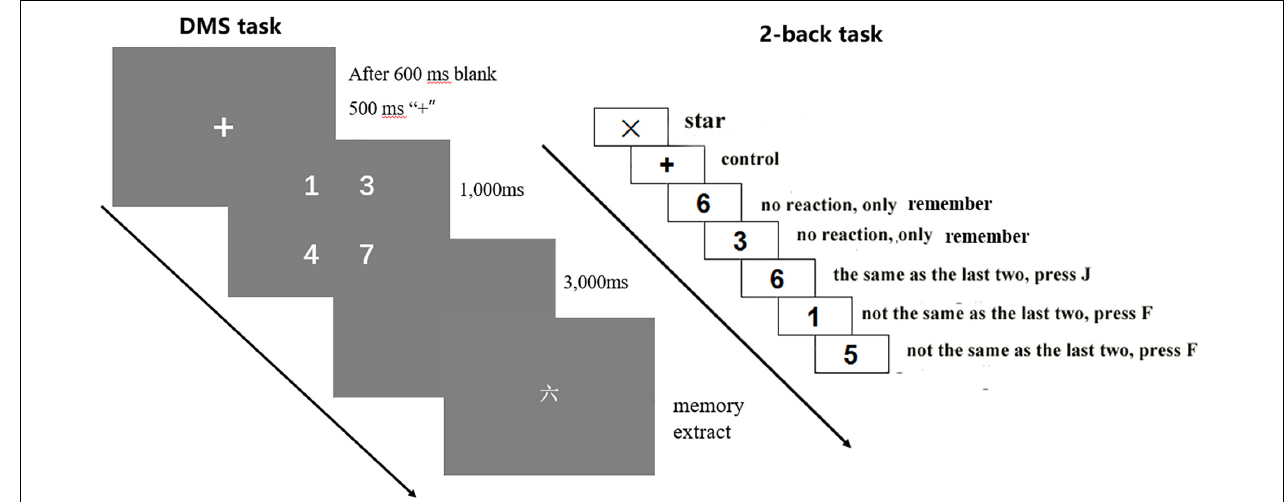
FIGURE 1 | Working memory